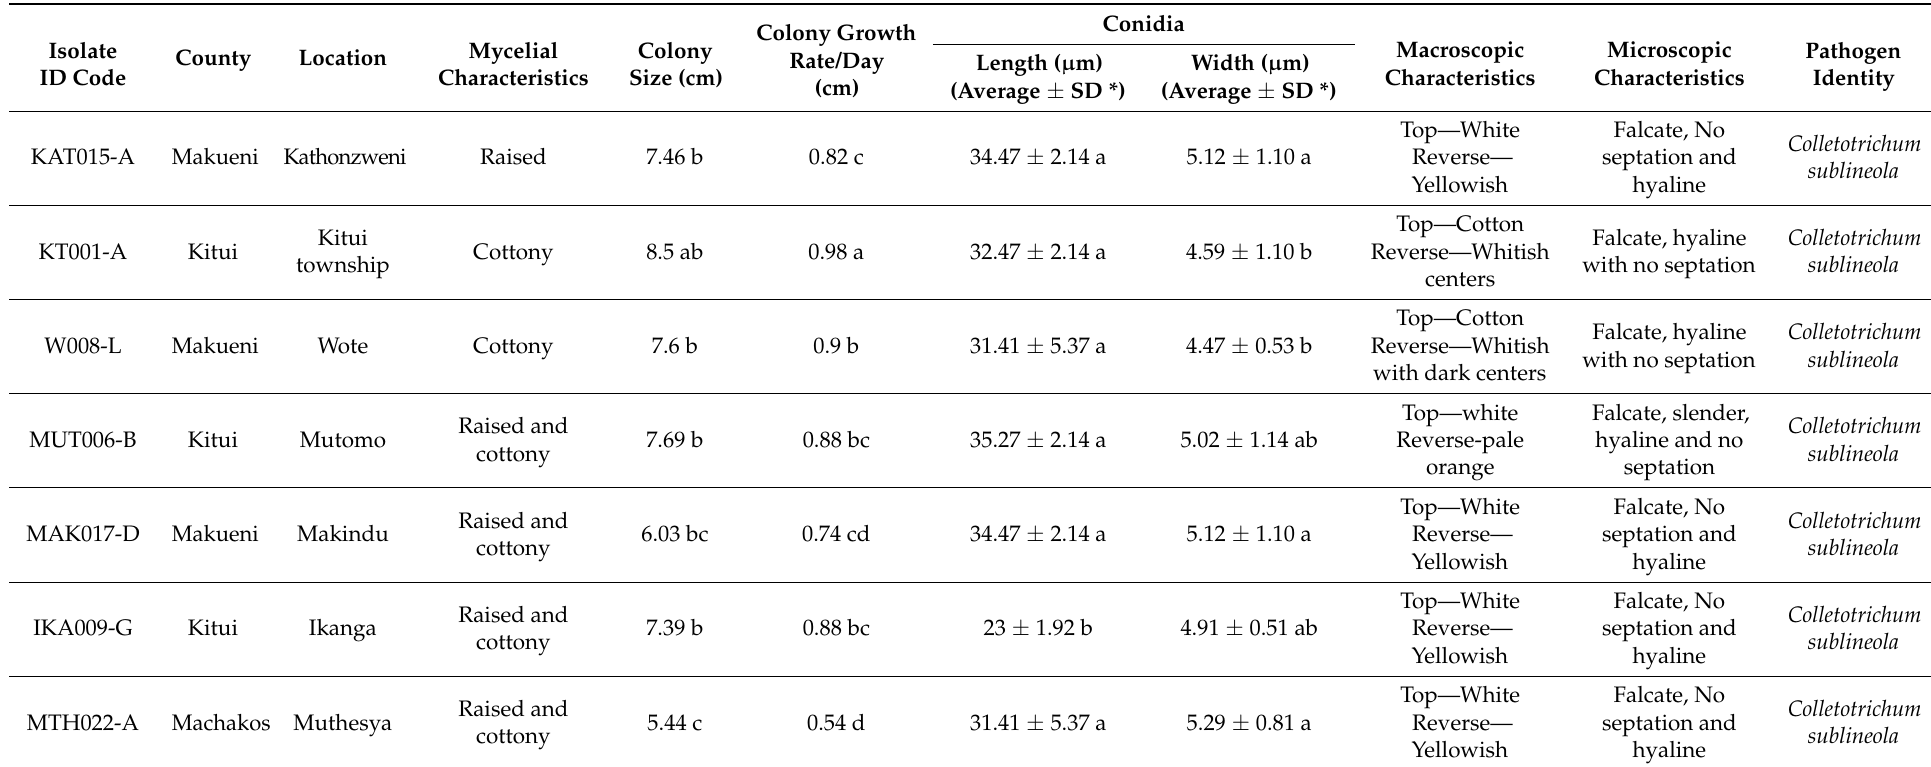
Table 3. Morpho-cultural characteristics of Colletotrichum isolates in lower eastern